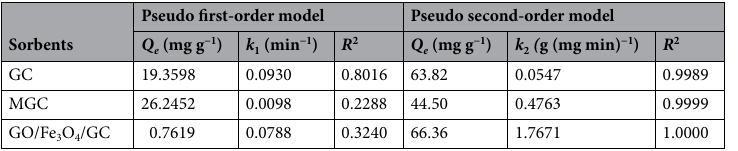
Table 3. Parameters of the pseudo first-order and second-order kinetic models for U adsorption on GC, MGC and GO/Fe 3 O 4 /GC.